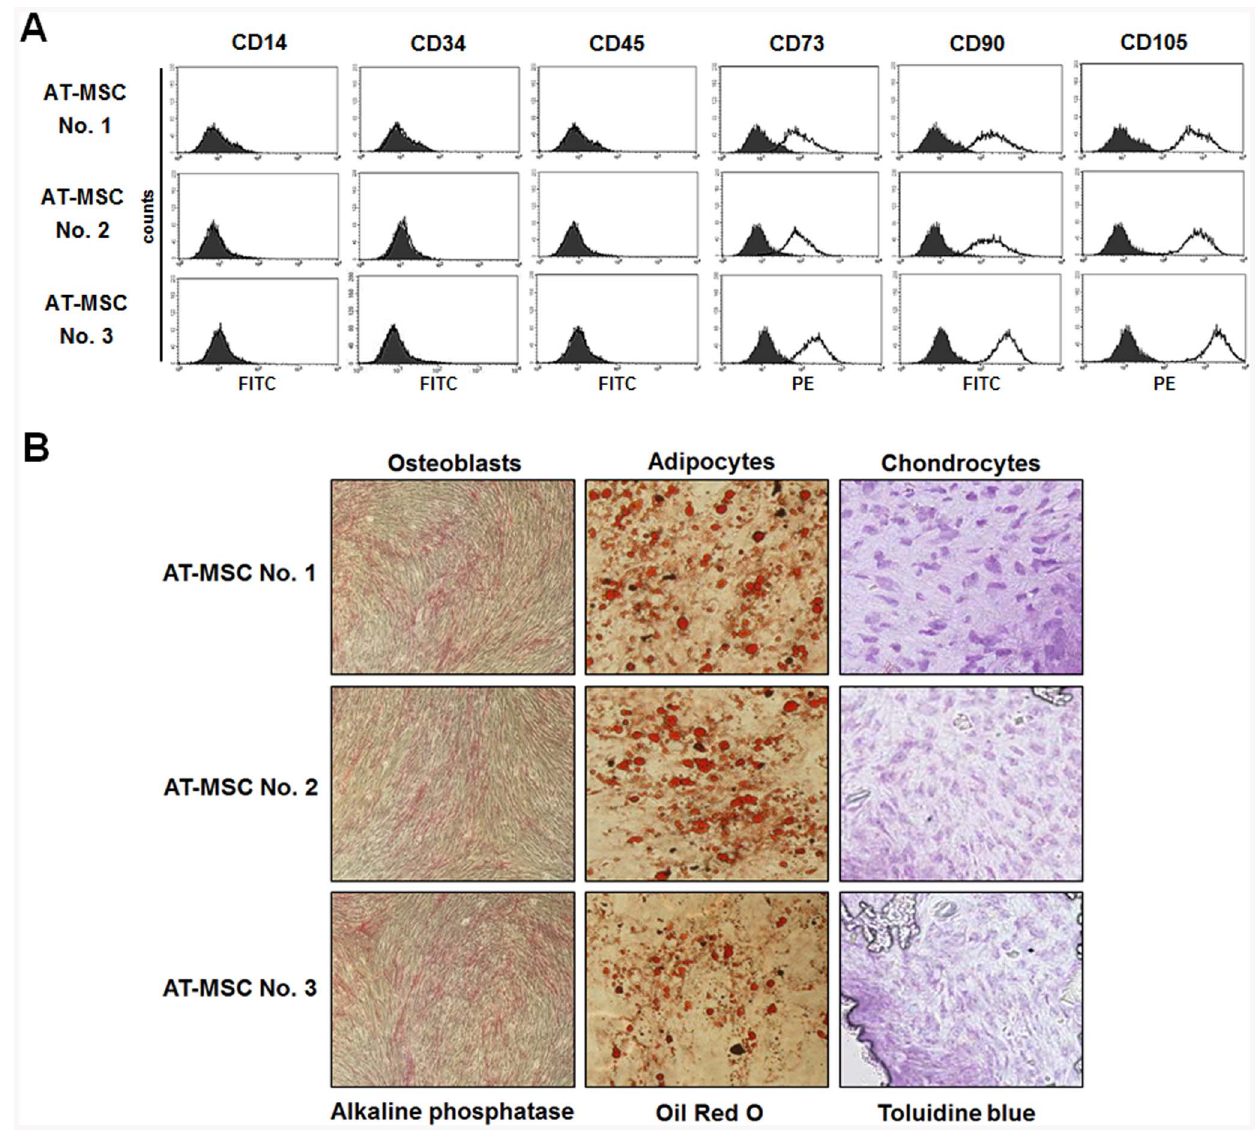
Figure 1. Characterization of AT-MSCs from three different donors. ( A ) The immunophenotype of AT-MSCs from three donors was analyzed by flow cytometry. The expression of surface antigens was plotted against appropriate IgG isotype controls (black histogram). MSCs used for the analyses were positive for CD73, CD90 and CD105, and negative for CD14, CD34 and CD45 (clear histogram). The histograms presented are representative of 3 independent experiments. ( B ) Differentiation of AT-MSCs from three donors. Cells were incubated for 14–21 days in the presence of specific differentiation agents for osteoblasts, chondrocytes, and adipocytes. Alkaline phosphatase staining shows mineralization of the extracellular matrix. Toluidine Blue staining shows the deposition of proteoglycans and lacunae. Differentiation into the adipocyte lineage was demonstrated by staining with Oil Red O. (Magnification: 6 100).